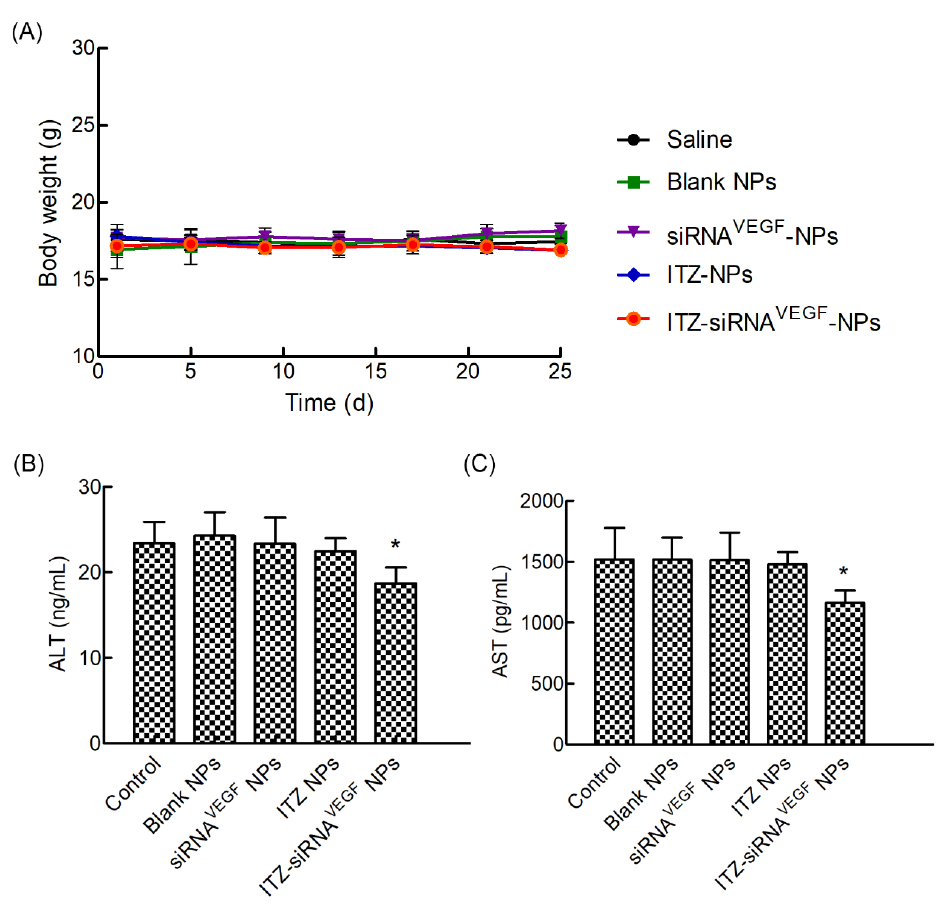
Figure 10. ( A ) The changes of body weight of in vivo anti-tumor effects of systemic administration of ITZ and VEGF siRNA codelivery NPs in 4T1 Luc tumor-bearing mice. ( n = 4). ( B ) Mouse ALT levels in the serum of the tumor-bearing mice at the end time point of the animal experiment were determined by ELISA ( n = 4). Data are provided as the mean ± SD. * p < 0.05, vs. saline. ( C ) Mouse AST levels in the serum of the tumor-bearing mice at the end time point of the animal experiment were determined by ELISA ( n = 4). Data are provided as the mean ± SD. * p < 0.05, vs.